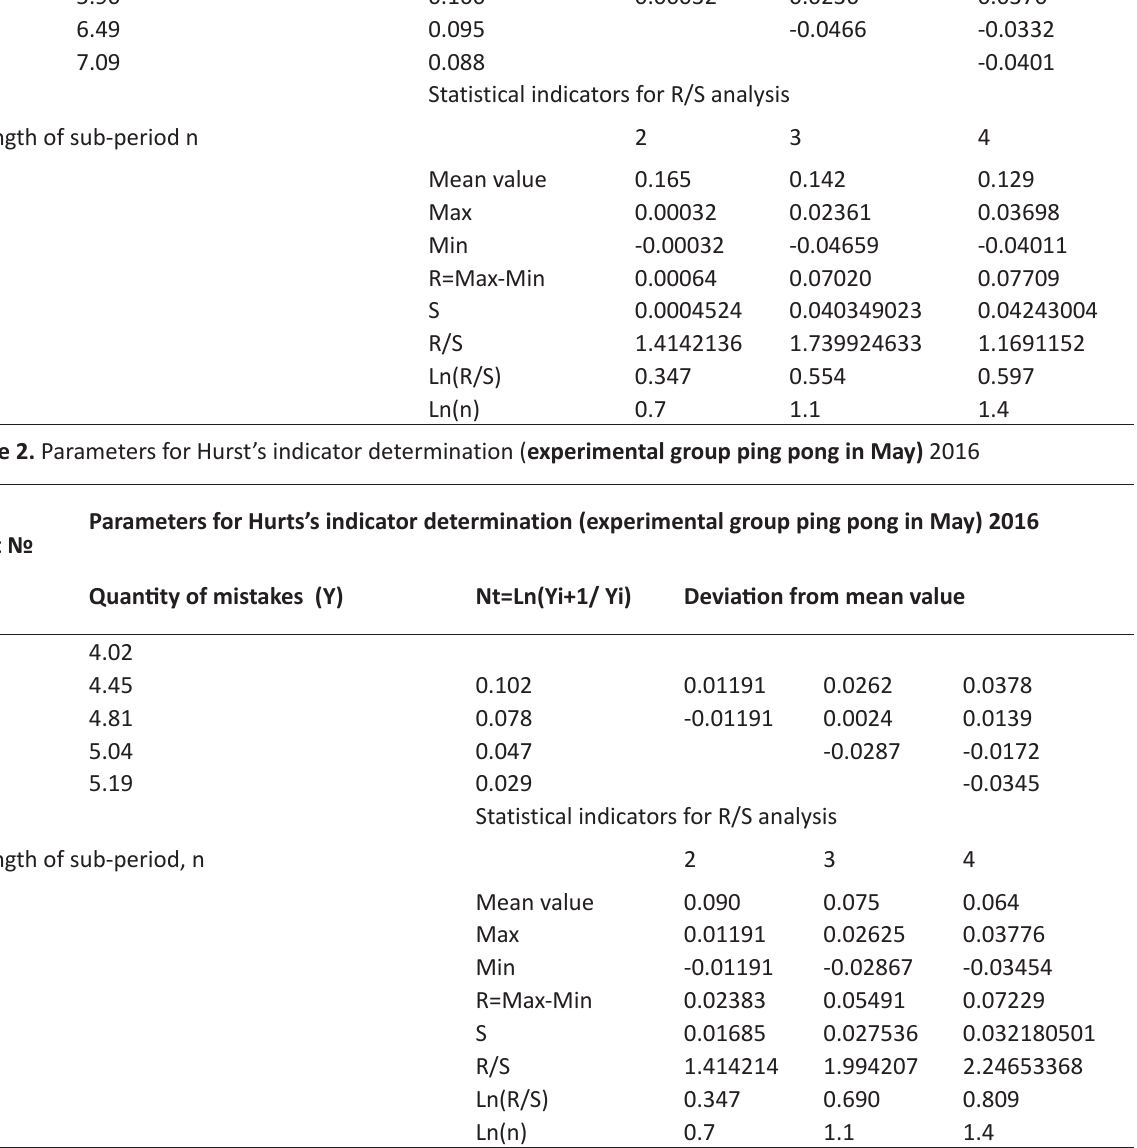
Length of sub-period,